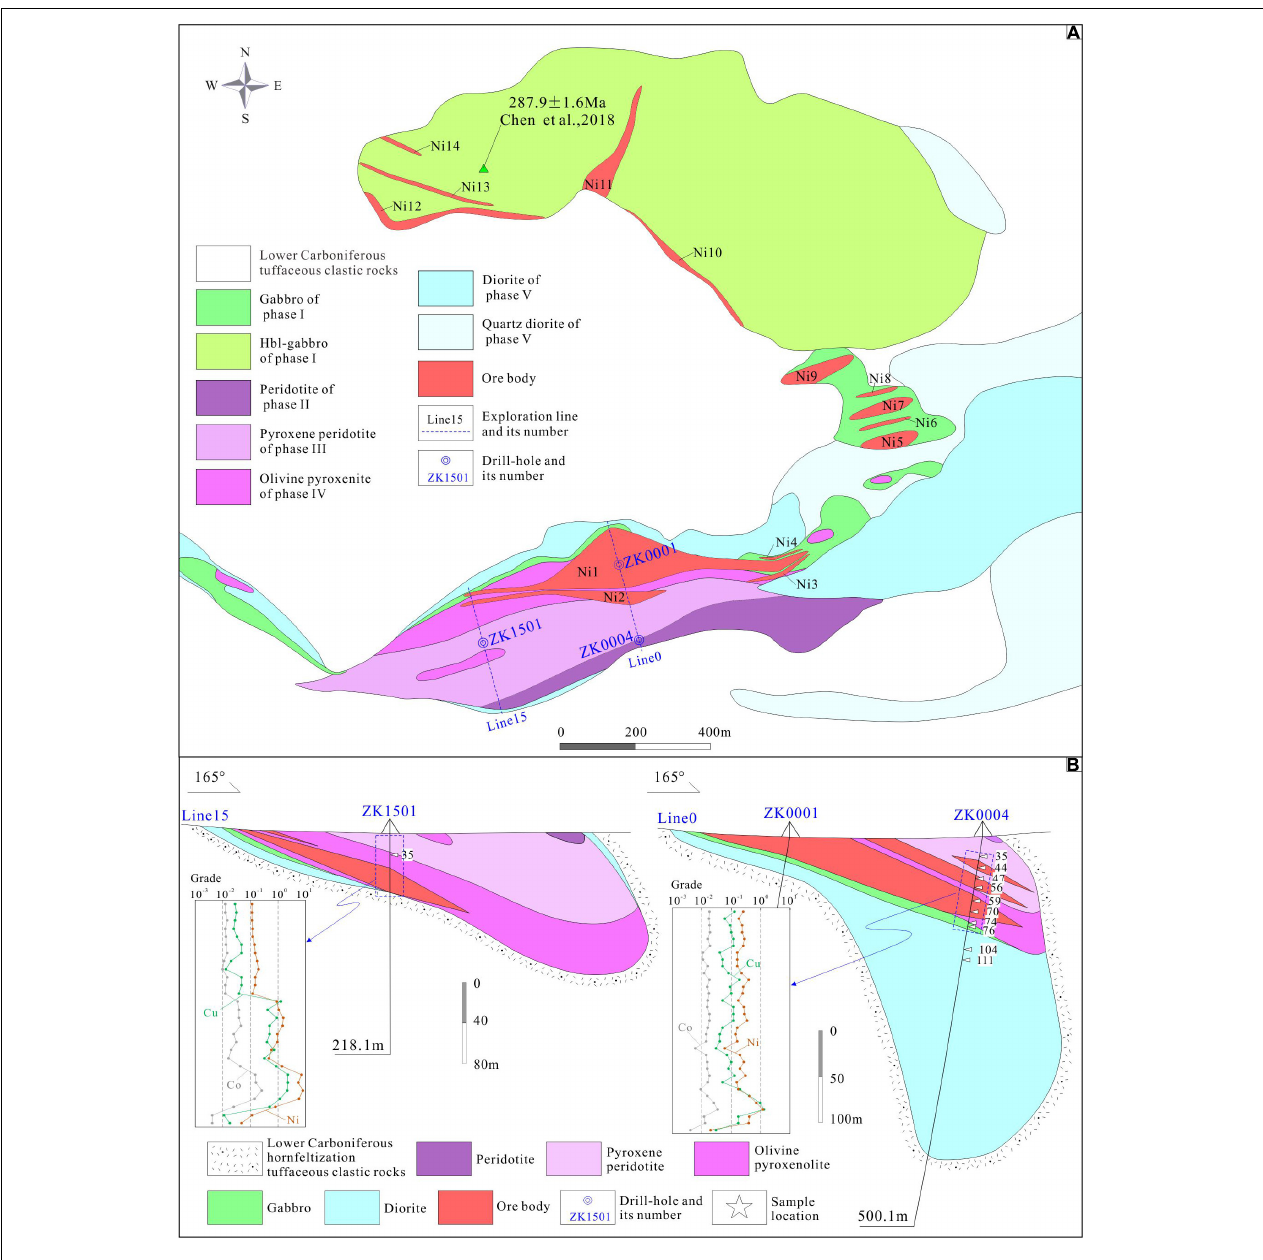
FIGURE 2 | Simplified geological map (A) and sample location (B) of the Lubei intrusion and Ni–Cu–Co orebodies.